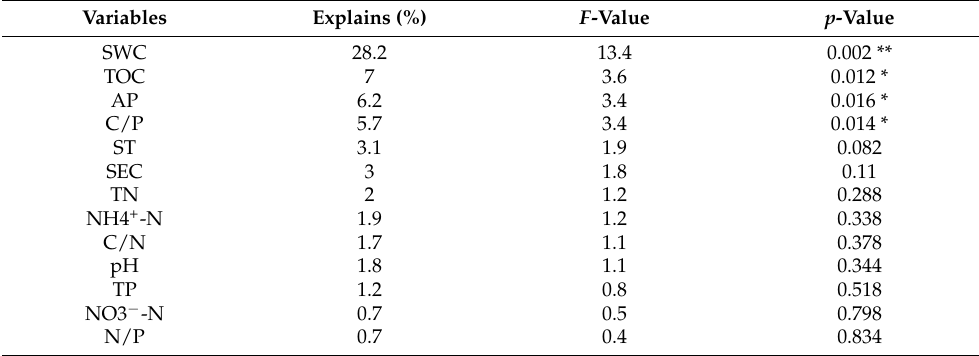
Table 3. Conditional effects of soil properties on soil microbial community composition obtained from the summary of forward selection in the redundancy analysis